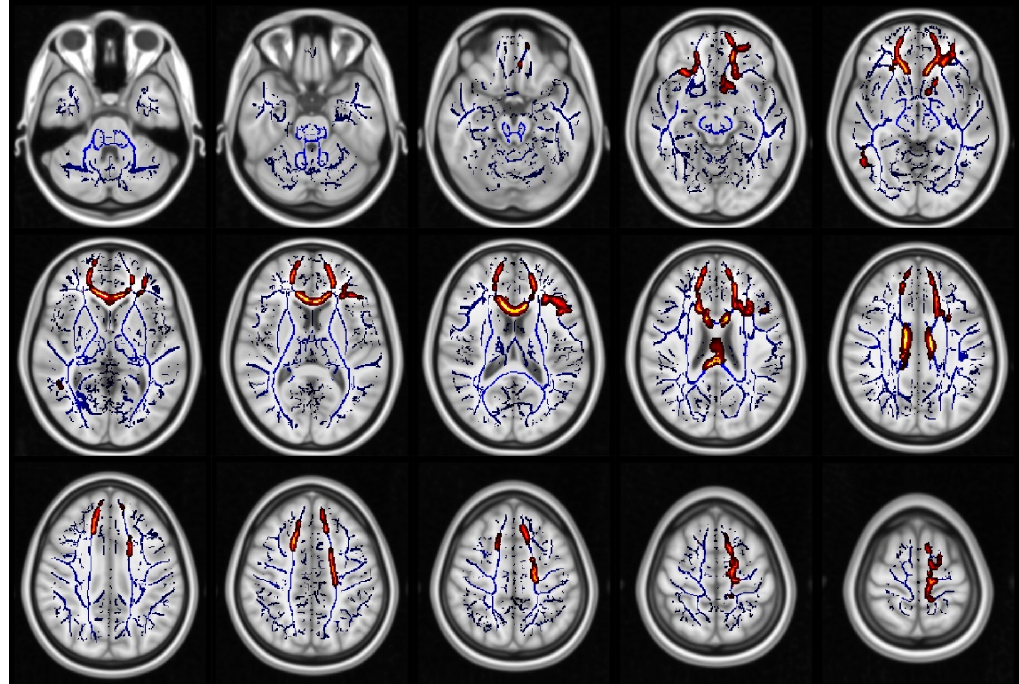
Figure 1. Regions which displayed significant differences in fractional anisotropy (FA) (displayed as red and yellow) (control (CTRL) > glaucoma group (GLA)). The white matter skeleton is shown in blue.